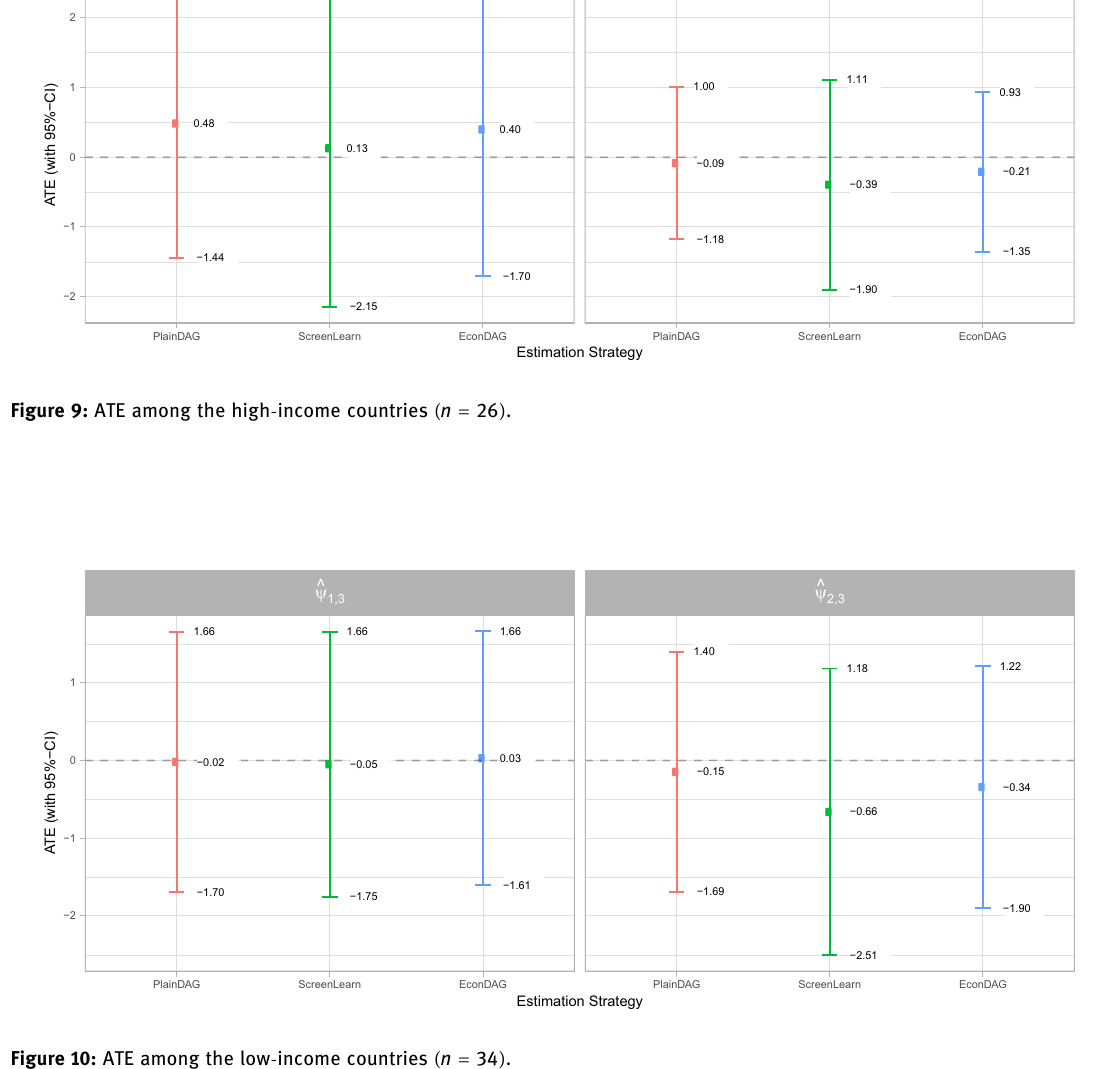
Figure 10: ATE among the low - income countries ( n 34 = )